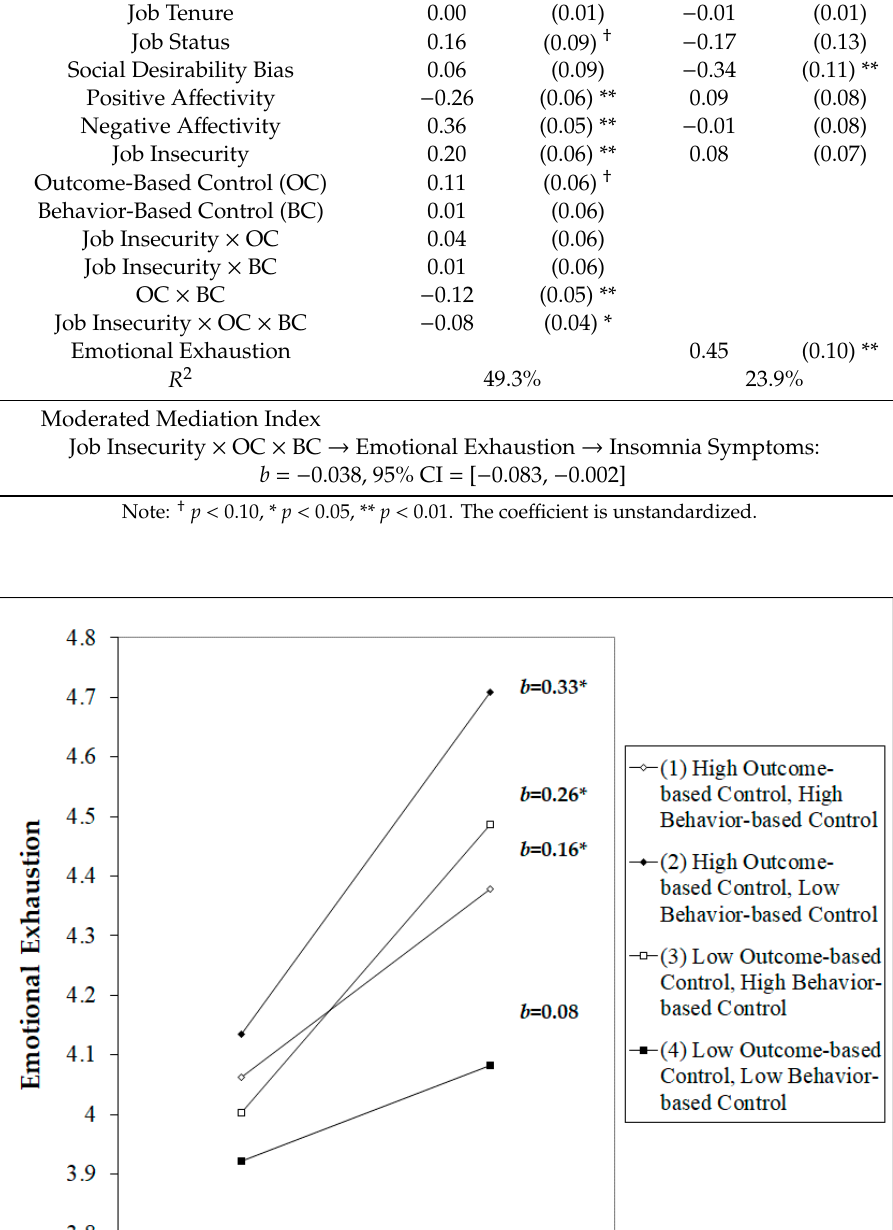
Table 4. Test of the moderating effects of outcome-based and behavior-based controls.